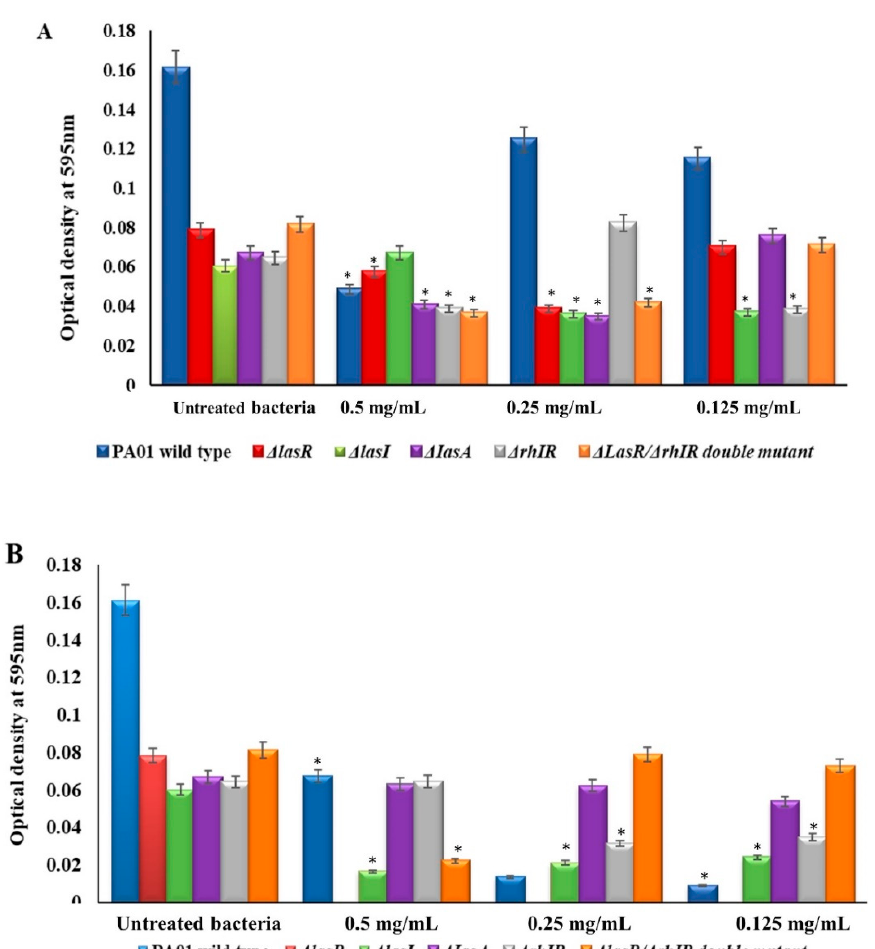
Figure 4. Pyocyanin production of P. aeruginosa strains. Levels of pyocyanin production of PA01, ∆ lasR , ∆ lasI , ∆ IasA , ∆ rhIR, and ∆ lasR / ∆ rhIR double mutant in the presence of 0.5–0.125 mg/mL of ( A ) mBTL or ( B ) mBTL-loaded CANPs were measured. Experiment performed in triplicate (mean ± SD). Based on Student t-test, (* p < 0.05) indicates significant reduction in pyocyanin production